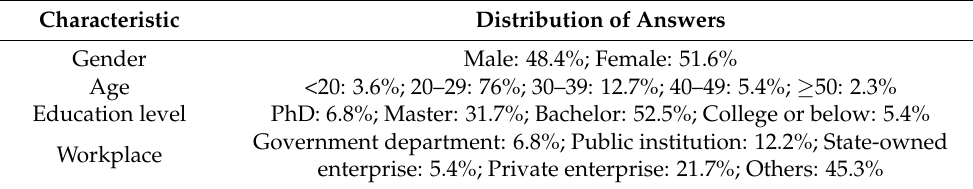
Table 1. Demographic characteristics of the respondents.